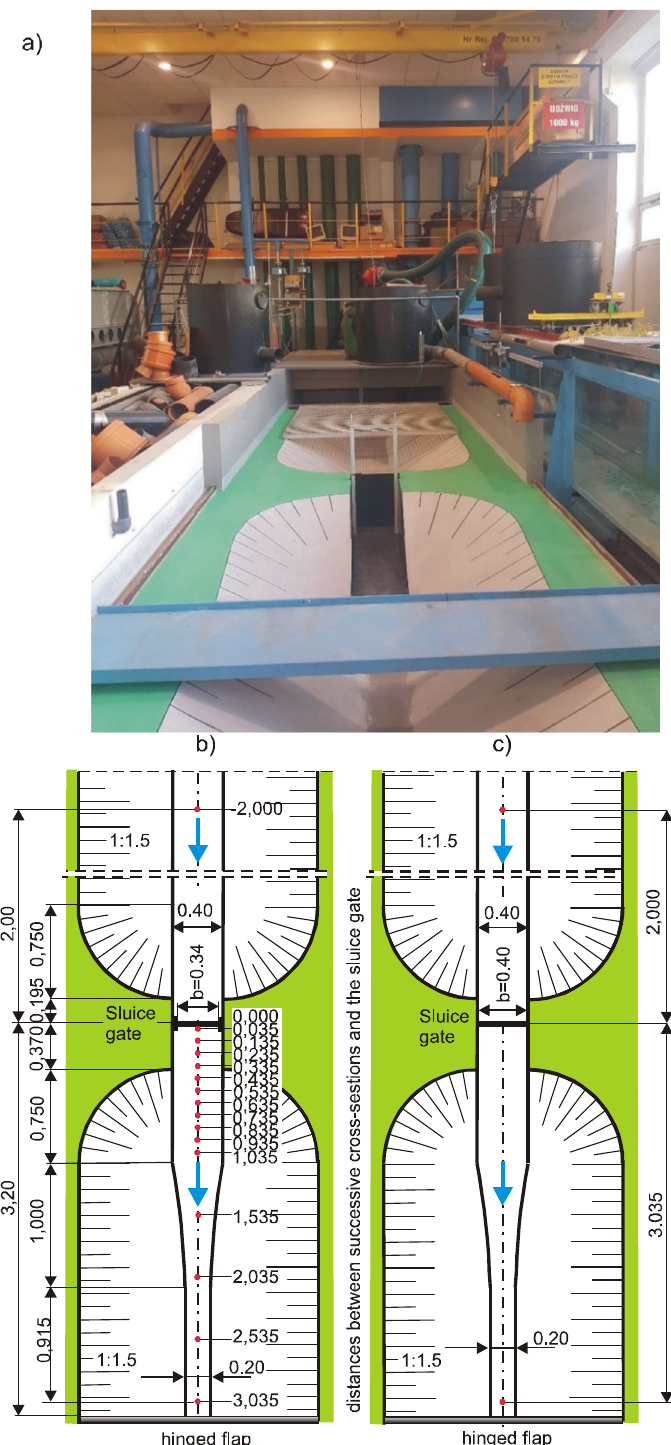
Figure 4 . The sluice gate model: ( a ) the view from the downstream stand in case V1, ( b ) depth measurement points in case V1, ( c ) depth measurement points in case V2 (dimensions in meters).